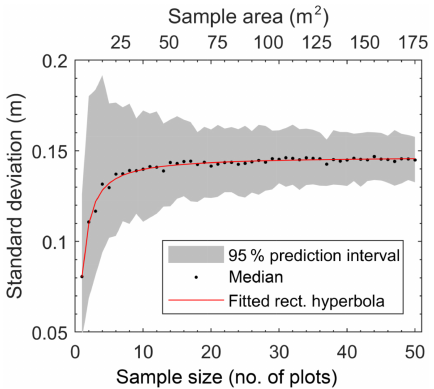
Figure 1. Site-level relation between standard deviation of micro- topographic variation based on total sample area for the Red Earth Creek site based on 50 ∼ 3 . 5m 2 plots. The grey shaded area repre- sents the 2.5th and 97.5th percentiles of standard deviation from the Monte Carlo resampling procedure.